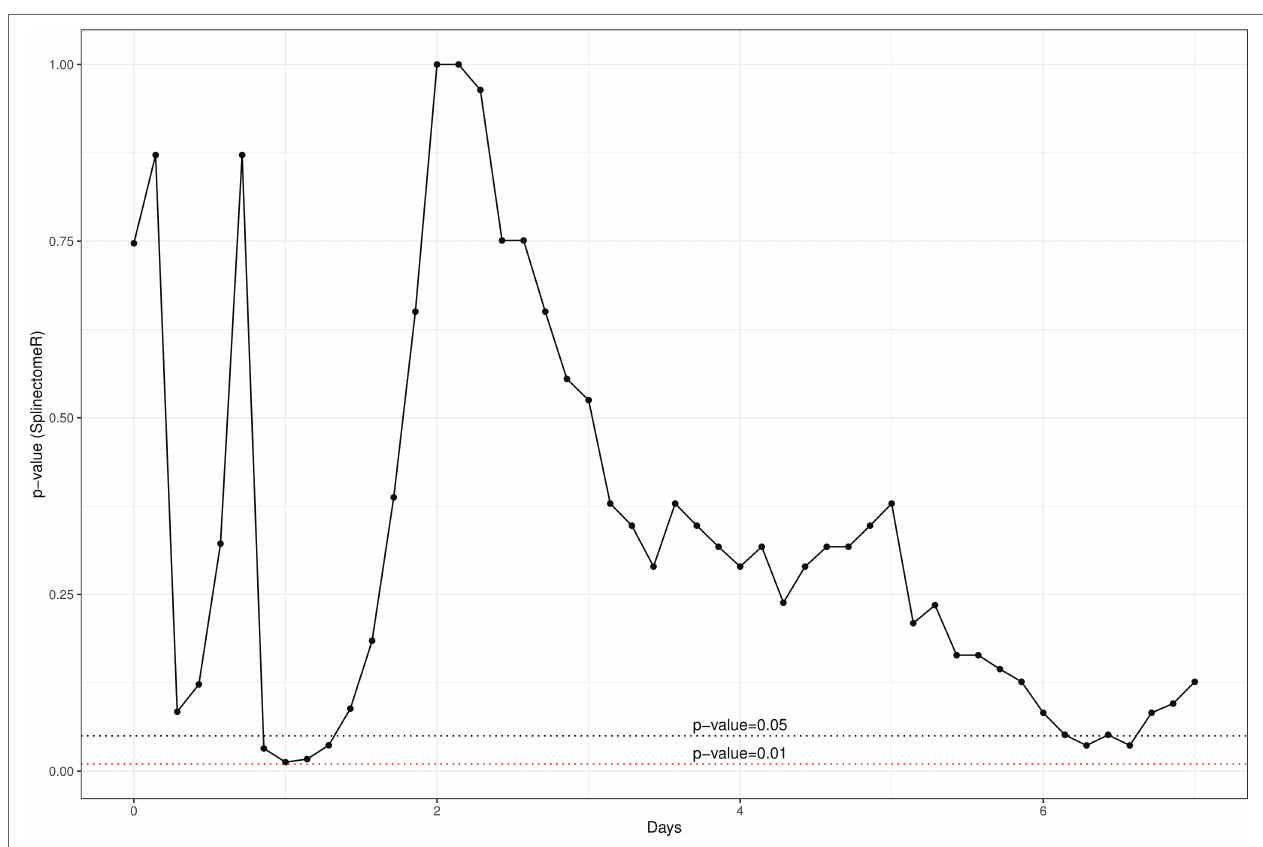
FIGURE 4 | A spline-based statistical tool was to compare the value of p of SCC values in the whole time series (R package splinectomeR; Shields-Cutler et al., 2018). Overall, the differences are not statistically significant for SCC between the two groups ( p = 0.38). However, this spline-based model predicts that the comparison is statistically significant at Day 0.25 (as shown previously in Figure 2 ) and also statistically significant between the two treatment groups on Day 5 and Day 7 ( p < 0.01). Overall, this spline-based analysis also indicates that heat-killed DPC3147 cells can be as efficacious as viable DPC3147 cells in terms of decreasing SCC count in mastitic